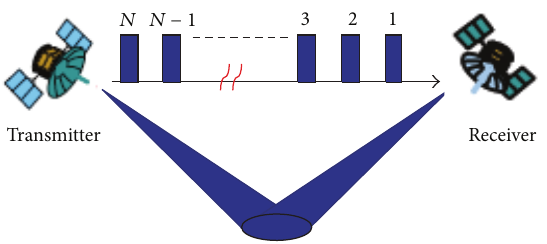
Figure 1: Model of the time and frequency synchronization